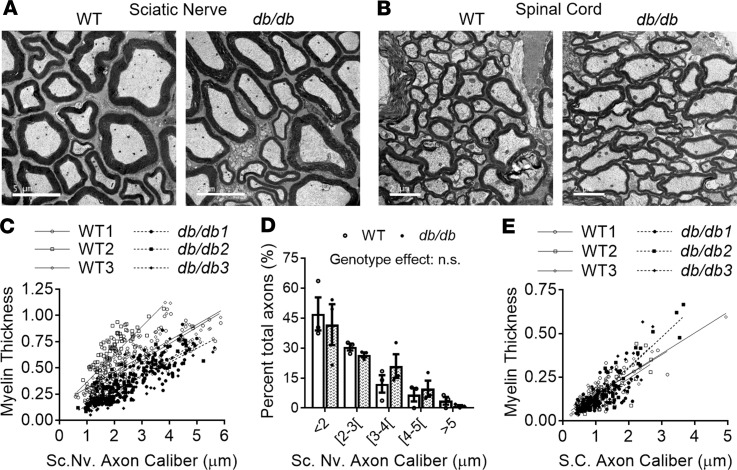
Disruption of myelin but not axonal PNS nerve ultrastructure in obese diabetic mice.Representative electron microscope (EM) cross-sectional images from the sciatic nerve (A) and spinal cord (B) (scale bars: 5 μm and 2 μm, respectively) of 4-month-old WT and db/db male mice. Scatter plots displaying myelin thickness of individual myelinated axons as a function of their respective average axon diameter (caliber) within the sciatic nerve (C) and spinal cord (E) in WT (open shapes and lines) and db/db (dotted shapes and broken lines) mice. Linear regression curves fitting the axonal data points (sciatic nerve n = ~100 axons/mice, spinal cord n = ~50 axons/mice) are displayed for each animal. (D) Sciatic nerve axons were categorized according to caliber; data are shown as the mean ± SEM of n = 3 male mice/genotype/tissue for all panels. Axon categories were compared between genotypes using 2-way ANOVA and Holm-Šidák multiple comparisons tests.